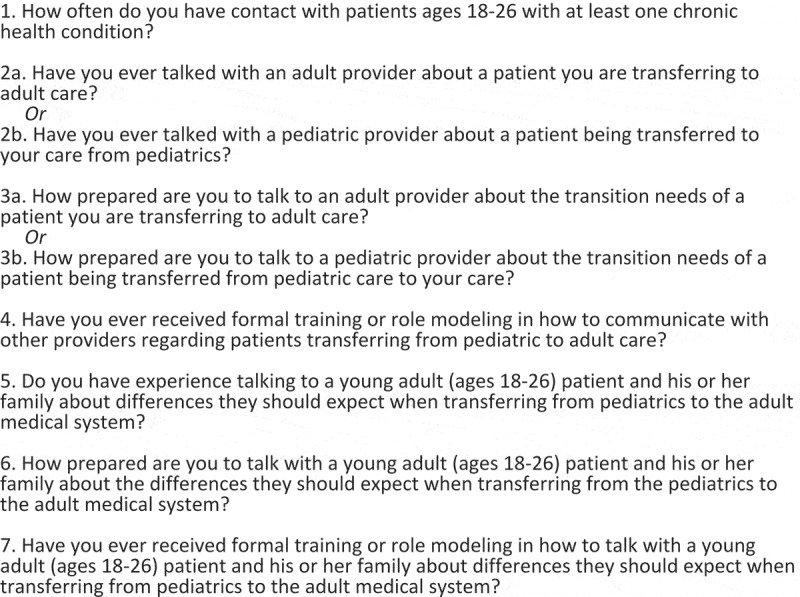
Survey questions.